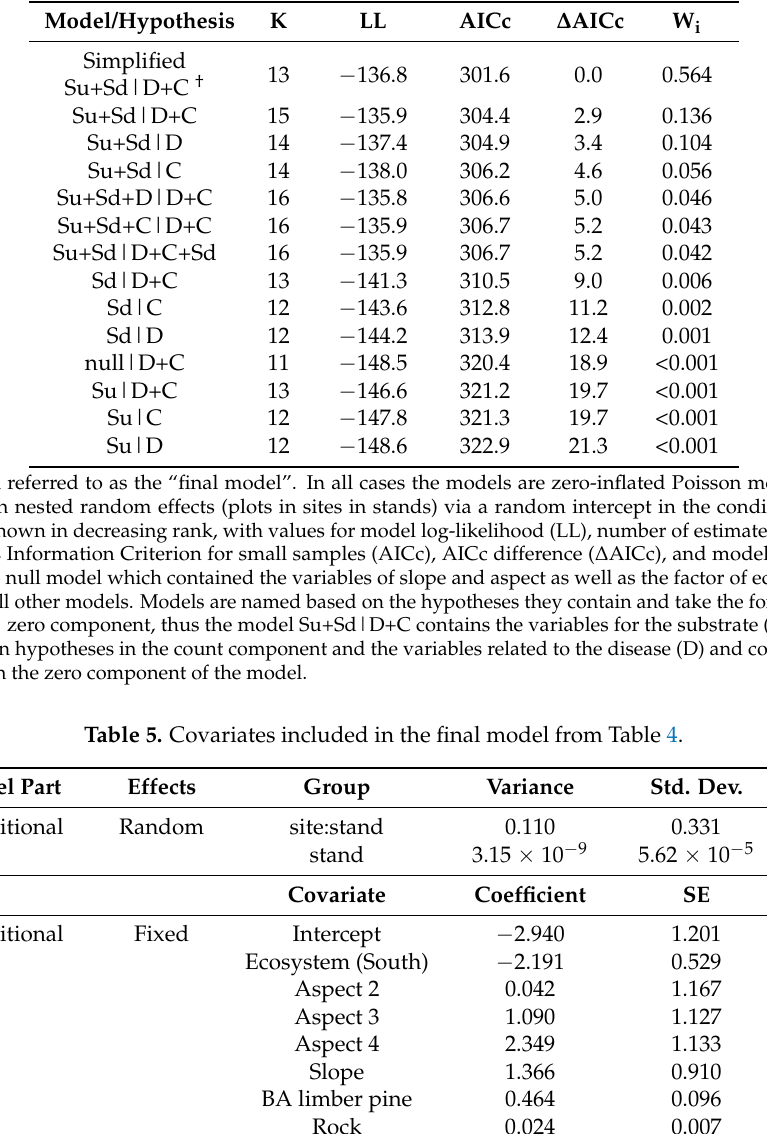
Table 4. Model selection results from candidate models for the regeneration of limber pine seedlings.